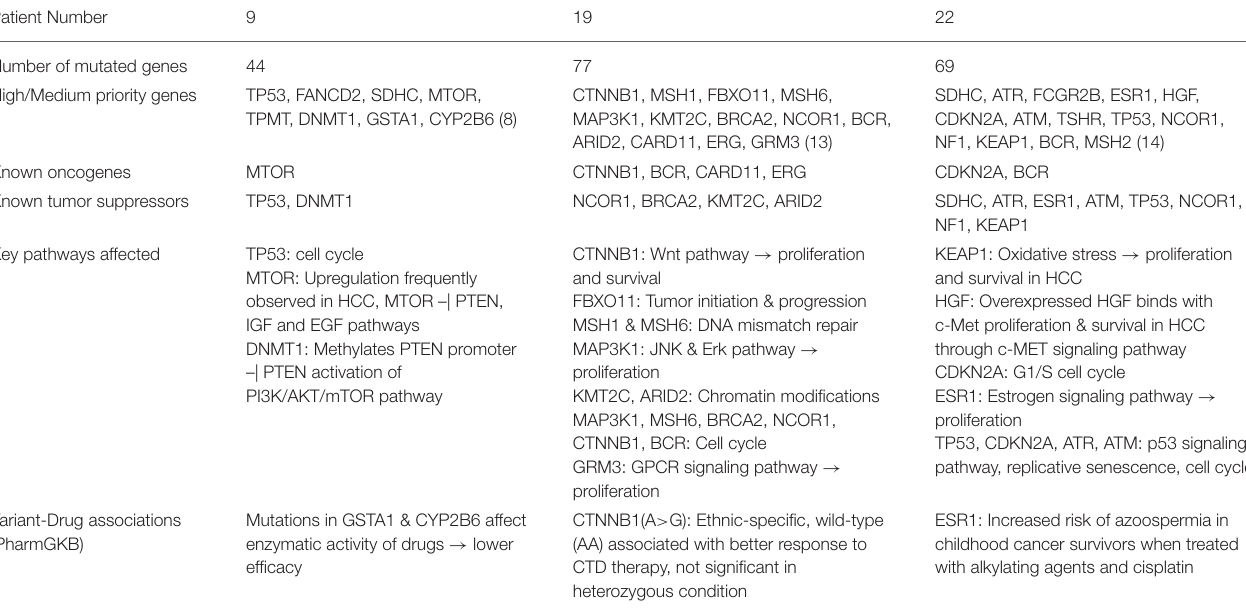
TABLE 7 | Summary of sequence variants and their functional role identified in HCC patient 9 (39 yr old, male), patient 19 (56 yr old, male), and patient 22 (60 yr old,